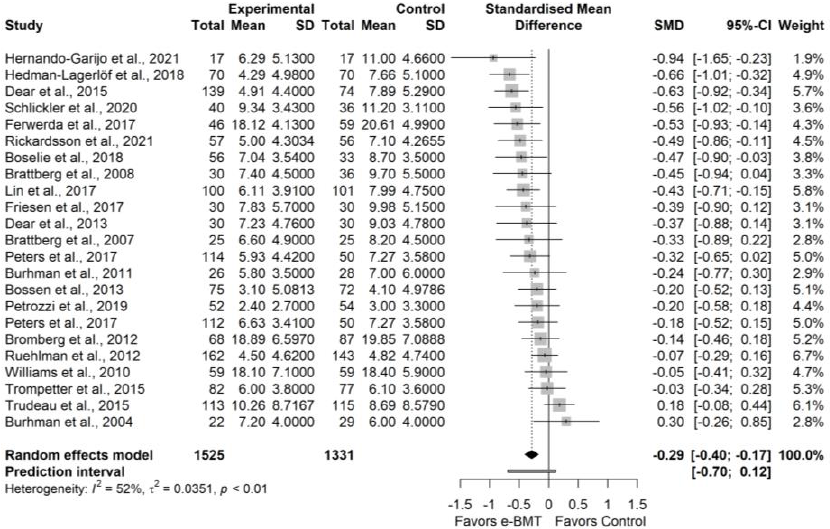
Figure A11. Forest plot with all the studies.